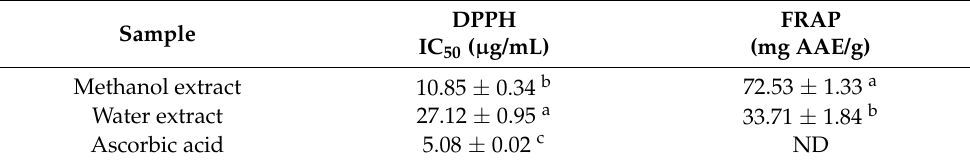
Table 2. DPPH and FRAP of methanol and water extracts of P. malayana leaves.